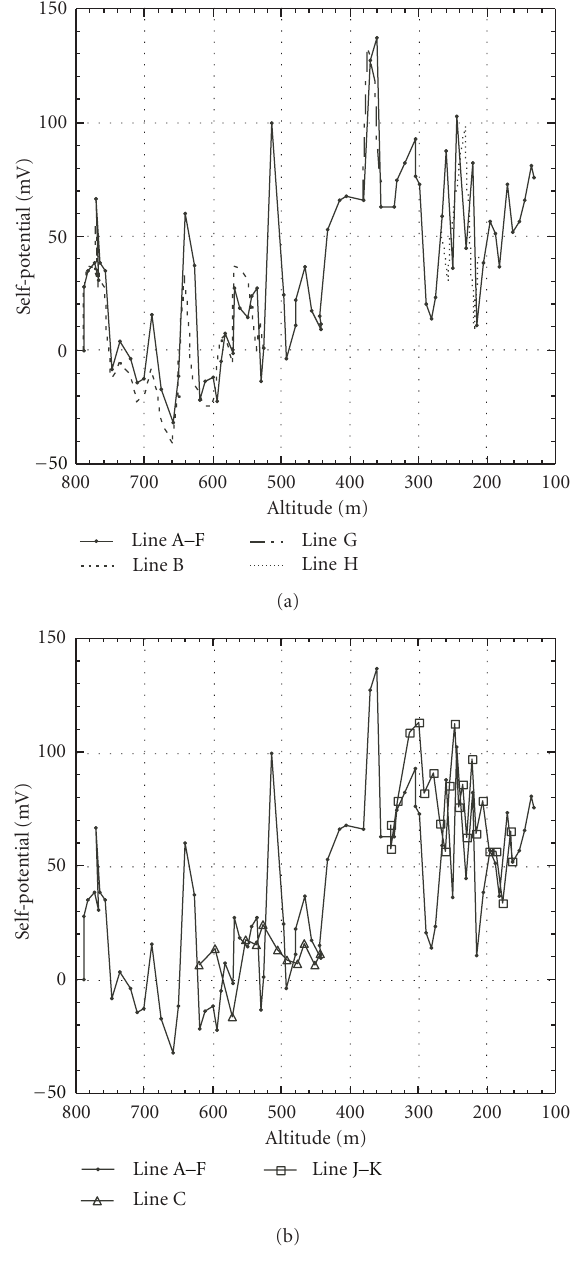
Figure 3: Observed SP profile along the northern slope of Mt. Tsukuba. (a) Those along the neighboring routes (A, F, B, G, and H) and (b) the parallel routes (C, J, and K) are plotted. The reference point is at the summit.